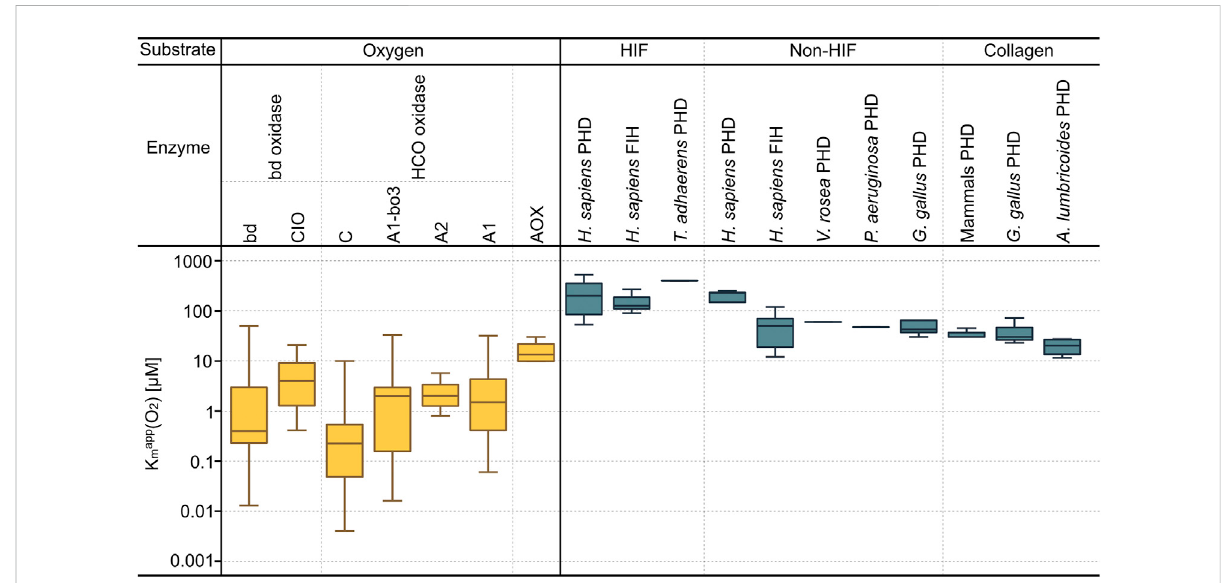
FIGURE 3 The K m app (O 2 ) values of terminal oxidases and oxygen sensing enzymes. On the left (yellow) K m app (O 2 ) values of the three main families of terminaloxidasesareshown andindicated ontheright(darkcyan)areK m app (O 2 )values ofoxygensensing enzymes(PHDs andFIH).Forcytochrome bd oxidases, two subtypes (bd and CIO) are shown; for HCOs, four subtypes (C, A1-bo3, A2, and A1) are shown. On the top the substrates of the enzymes are indicated; oxygen as substrate for terminal oxidases, as their main function is to reduce oxygen within organism organelles. The K m app (O 2 ) values of oxygen sensors (PHDs and FIH) are combined based on their substrates, which are sorted into three groups — HIF protein peptides, non-HIF protein peptides, and collagen. All underlying K m app (O 2 ) values are detailed in Supplementary Tables S3, S4 (AOX: Alternative Oxidase, CIO: Cyanide Insensitive Oxidase, HCO: Heme Copper